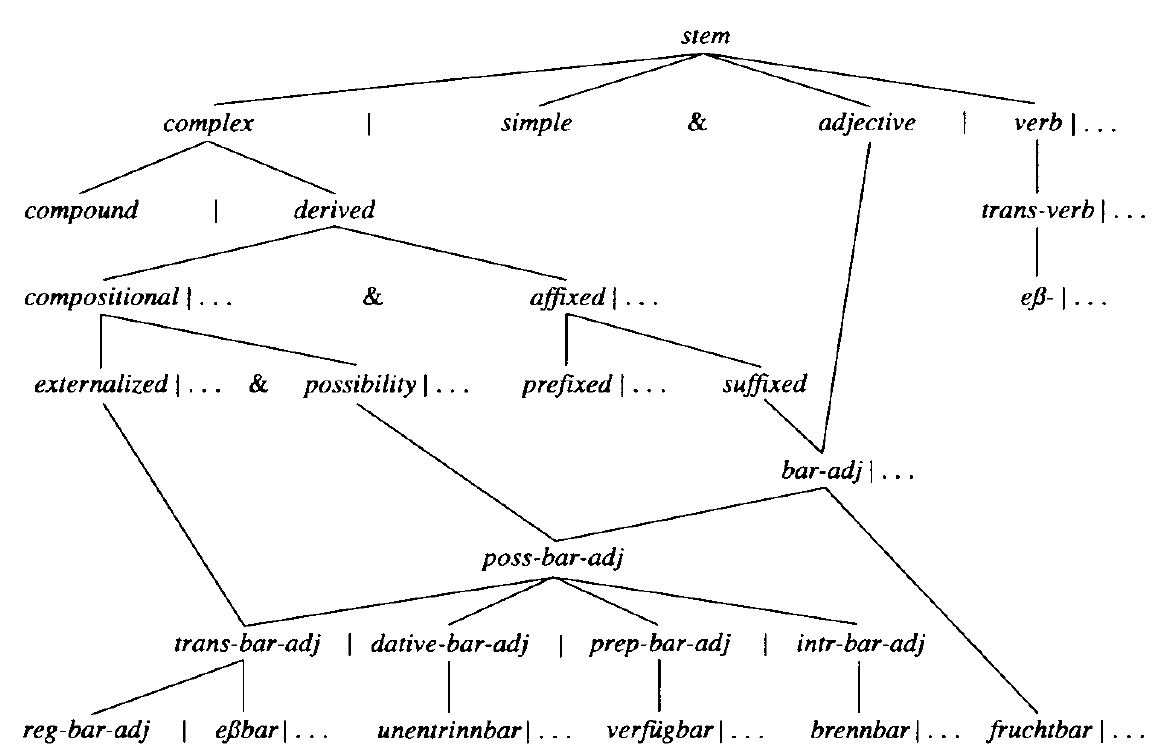
Figure 1: Type hierarchy for - bar ‘able’ derivation [Riehemann